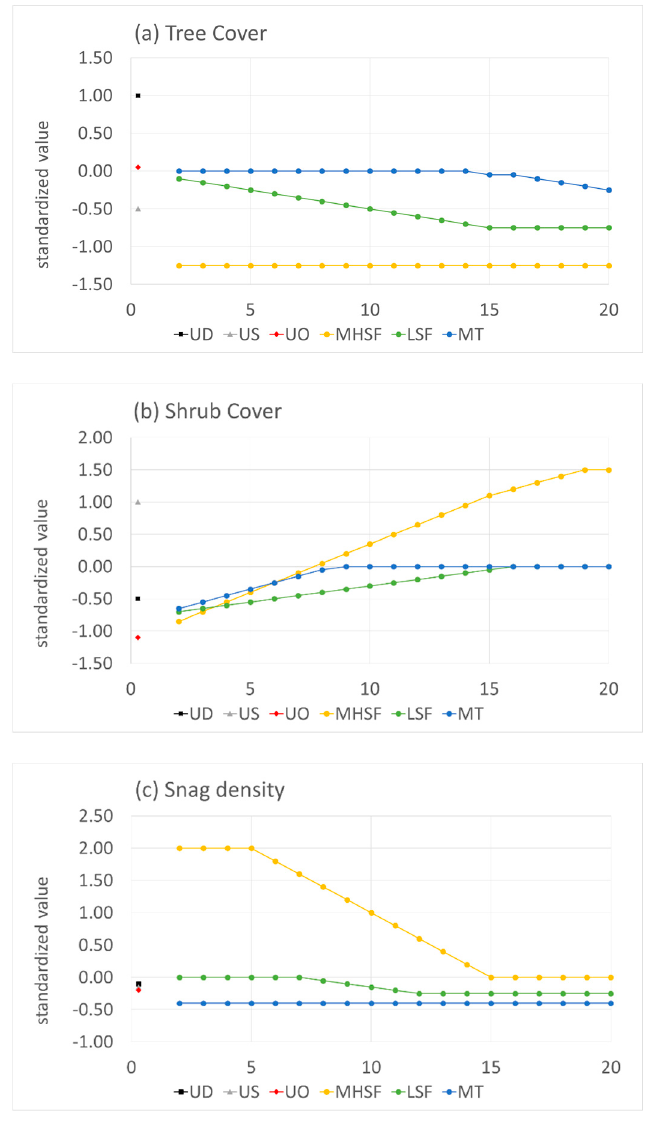
Figure A1. Vegetation values: ( a ) tree cover, ( b ) shrub cover, and ( c ) snag density used for modeling predicted abundance over time in each disturbance type. Scales of each figure are in standardized units (mean = 0.0, standard deviation = 1.0). Predicted abundances for each species were based on these measurements, time from 2 to 19 years, and average values (standardized value = 0.0) for all other